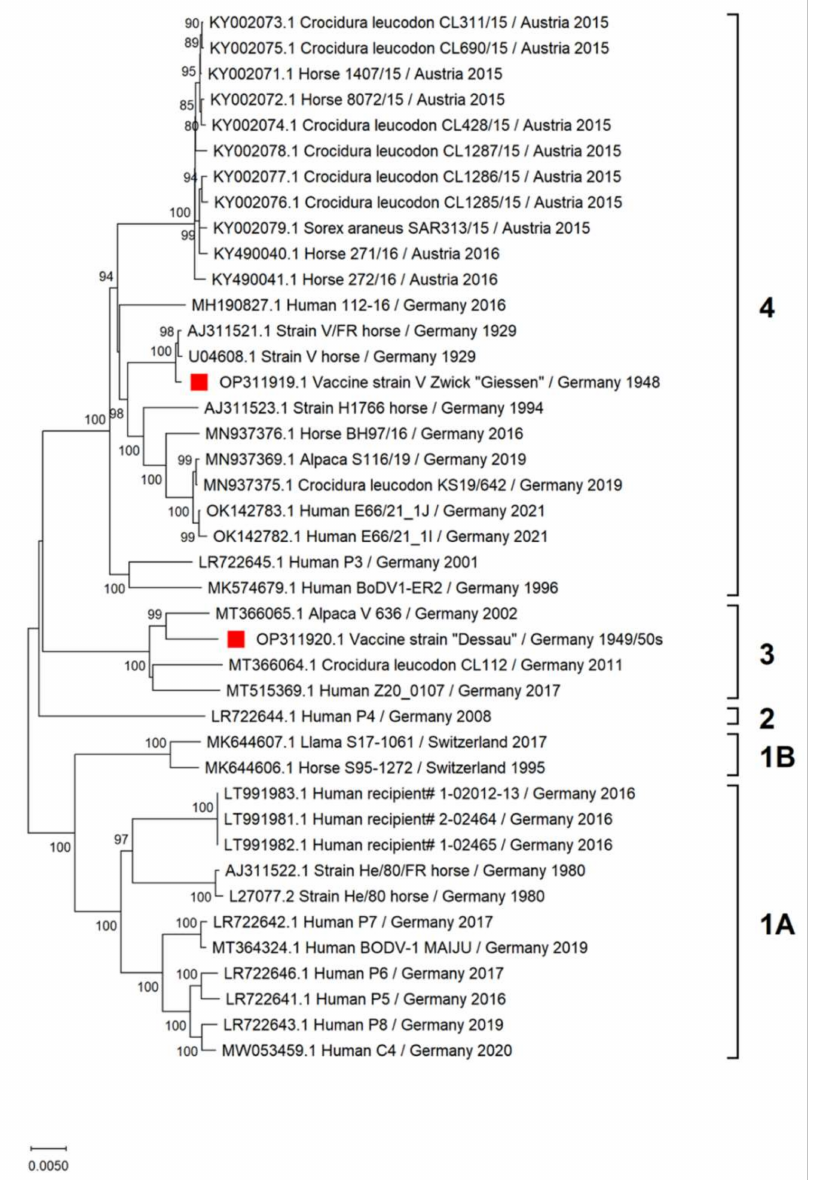
Figure 2. Phylogenetic analyses of the vaccine viruses Zwick “Giessen” and “Dessau” (red squares). The tree comprises 41 full genomes (8823 bp) of BoDV-1 (MEGA X, Neighbor-Joining method, p- distance model, pairwise deletion option, 1000 replicates, bootstrap values ≥